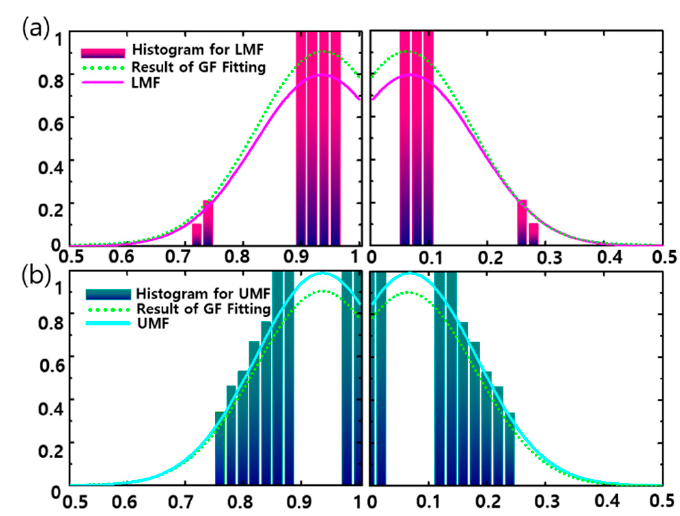
Figure 4. Histogram for fuzzifier value. ( a ) LMF histogram ( b ) UMF histogram